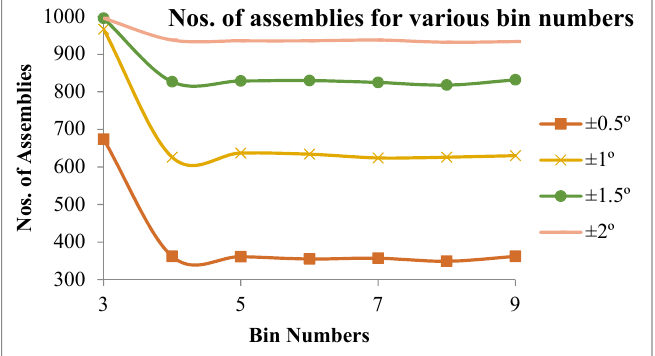
Figure 6. NoA vs. bin number for various assembly specifications for the 3213 process combination.